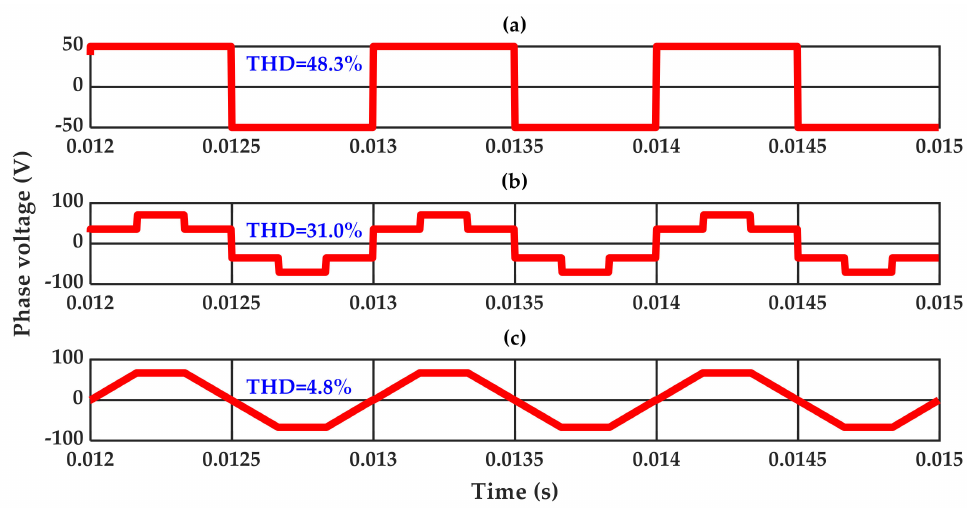
Figure 3. Three different types of supply waveforms considered in computations: square ( a ), six-step ( b ) and trapezoidal ( c